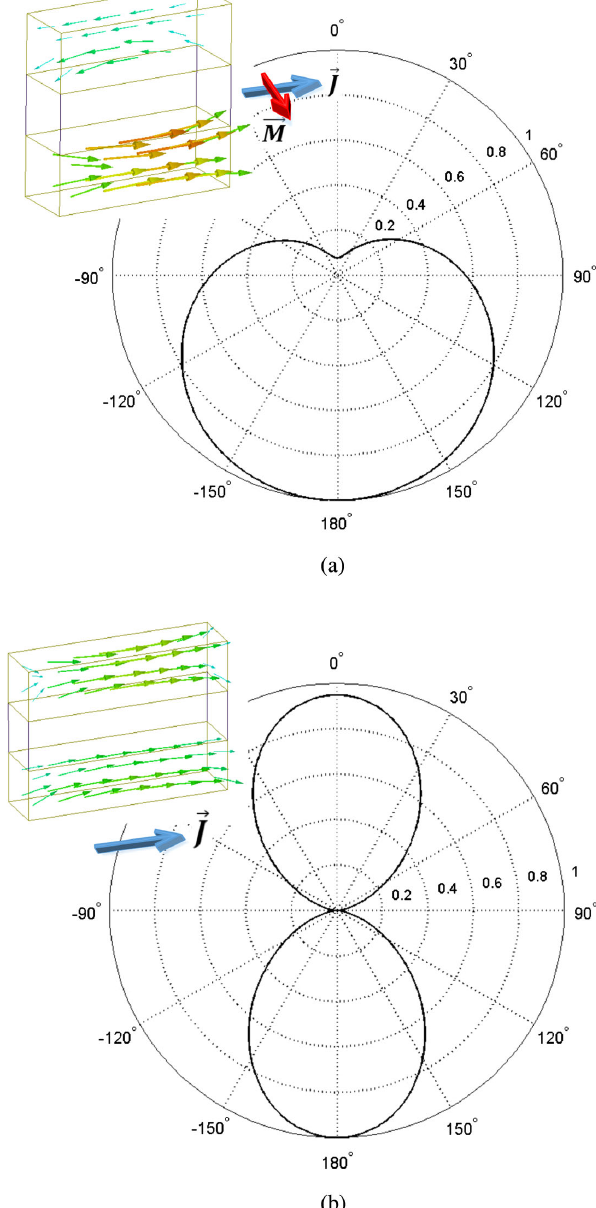
FIG. 4. Radiation pattern of a single isolated unit cell (a) when the GSP resonator simultaneously excites orthogonal electric and magnetic dipoles and (b) when the electric dipole is dominant. The insets show the induced current distribution upon normal plane-wave incidence at λ ¼ 800 nm. The dimensions of the two gold nanorods and silica spacer are (a) 50 nm × 50 nm × 140 nm and (b) 50 nm × 50 nm × 200 nm. Blue ( indicate the directions of induced electric and magnetic currents,